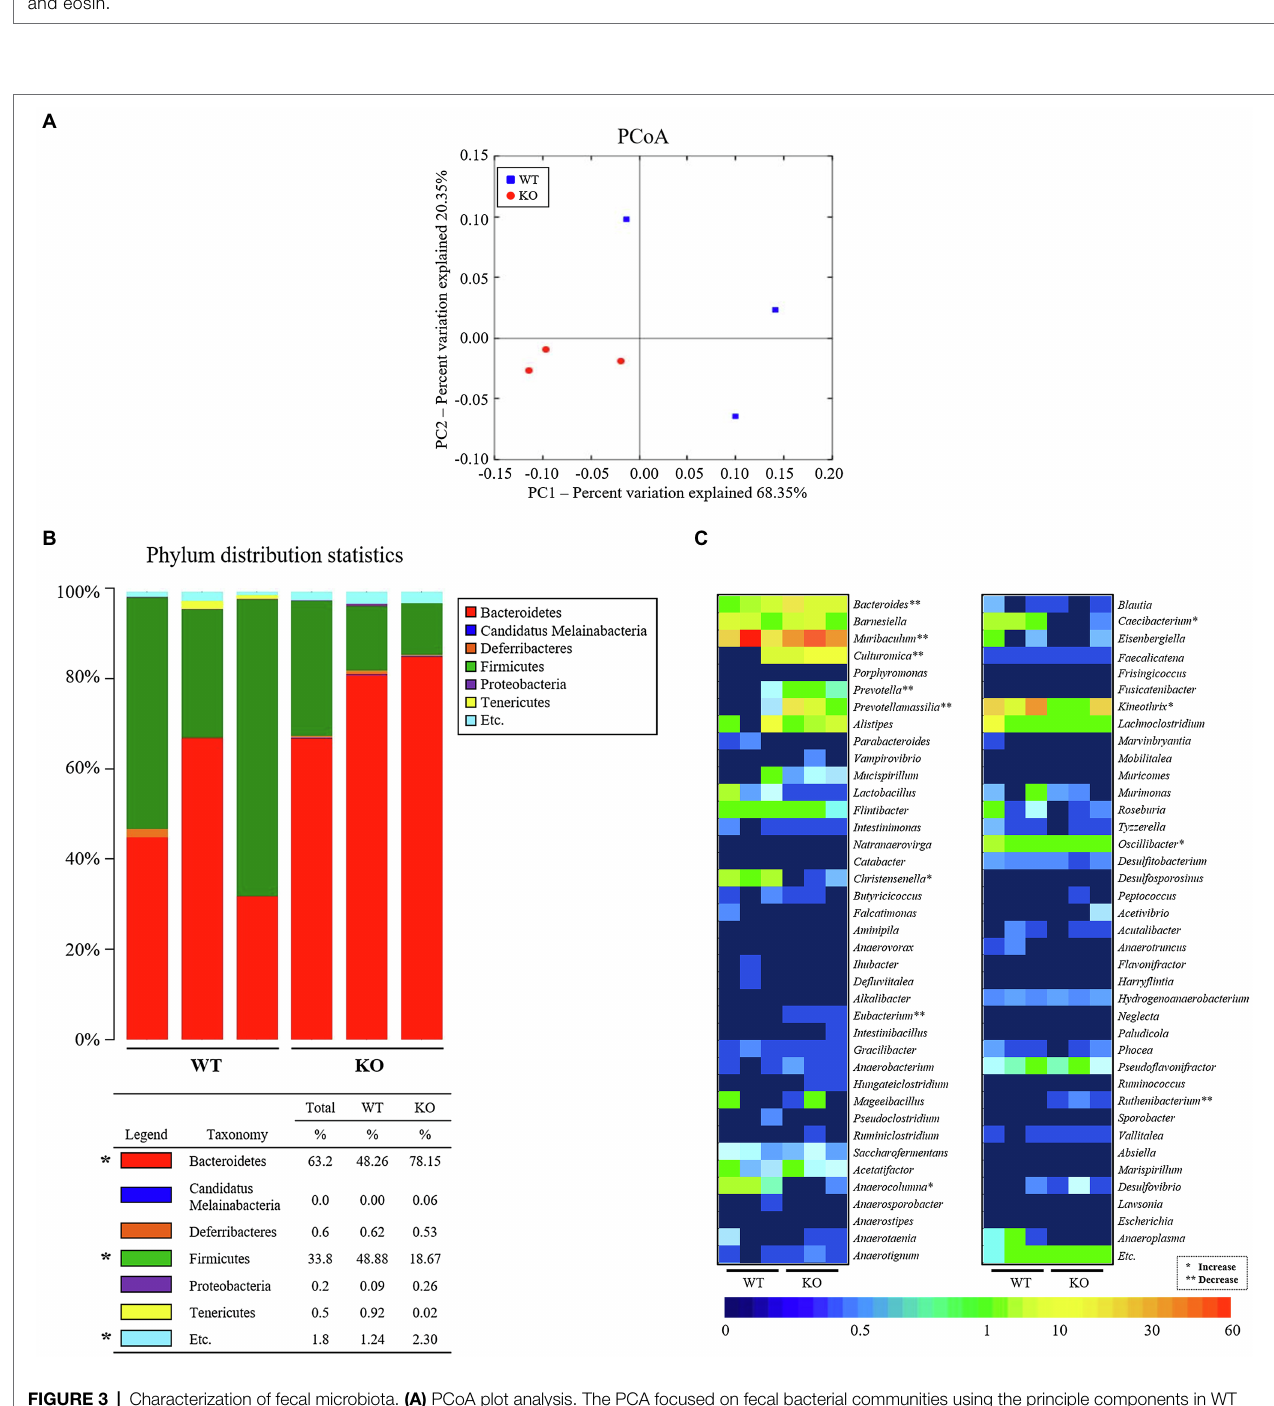
FIGURE 2 | were used for stool collection, and each parameter was assayed in duplicate. (B) H&E-stained sections of mid-colon from WT and KO mice were observed at 400x magnification using a light microscope. Histopathological parameters were determined using the Leica Application Suite. Three to five mice per group were used to prepare H&E-stained slides, and histopathological parameters were measured in duplicate in each slide. The data are reported as mean ± SD values. * p < 0.05 compared with the WT group. WT, wild type; KO, knockout; and H&E, hematoxylin and eosin.